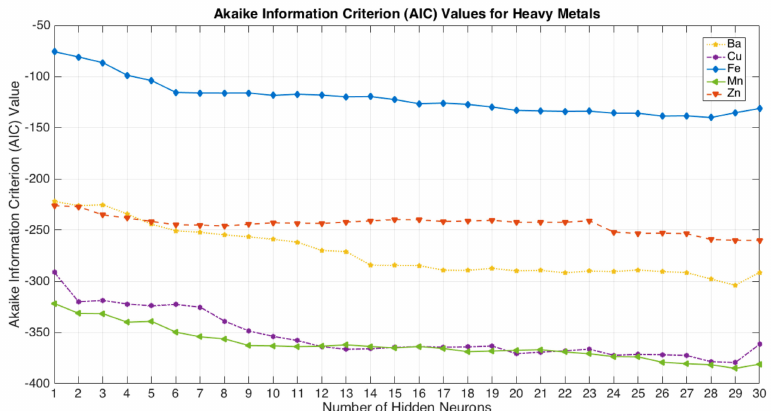
Figure 9. The AIC Values for Heavy Metals. The spatial concentration of the physicochemical parameters of GW in Calapan City, Oriental Mindoro was mapped using NN-PSO+EBK interpolation method. The highest temperature for GW recorded in the study area was 33.6 ◦ C which was observed in Brgy. Parang. While the least temperature was observed in Brgy. Biga with recorded temperature of 26.2 ◦ C. The highest pH for GW was observed at Brgy. Canubing I, with pH equal to 8.8. The lowest pH was detected at Brgy. Sto. Nino with pH of 6.7. The highest EC and TDS observed in Brgy. Ibaba West with EC and TDS value of 1820 µ S/cm and 900 ppm, respectively. The least observed EC and TDS concentration was 100 µ S/cm and 40 ppm, respectively which was recorded in Brgy. Sta. Rita. The spatial concentration of the physicochemical parameters of GW is shown in Figure